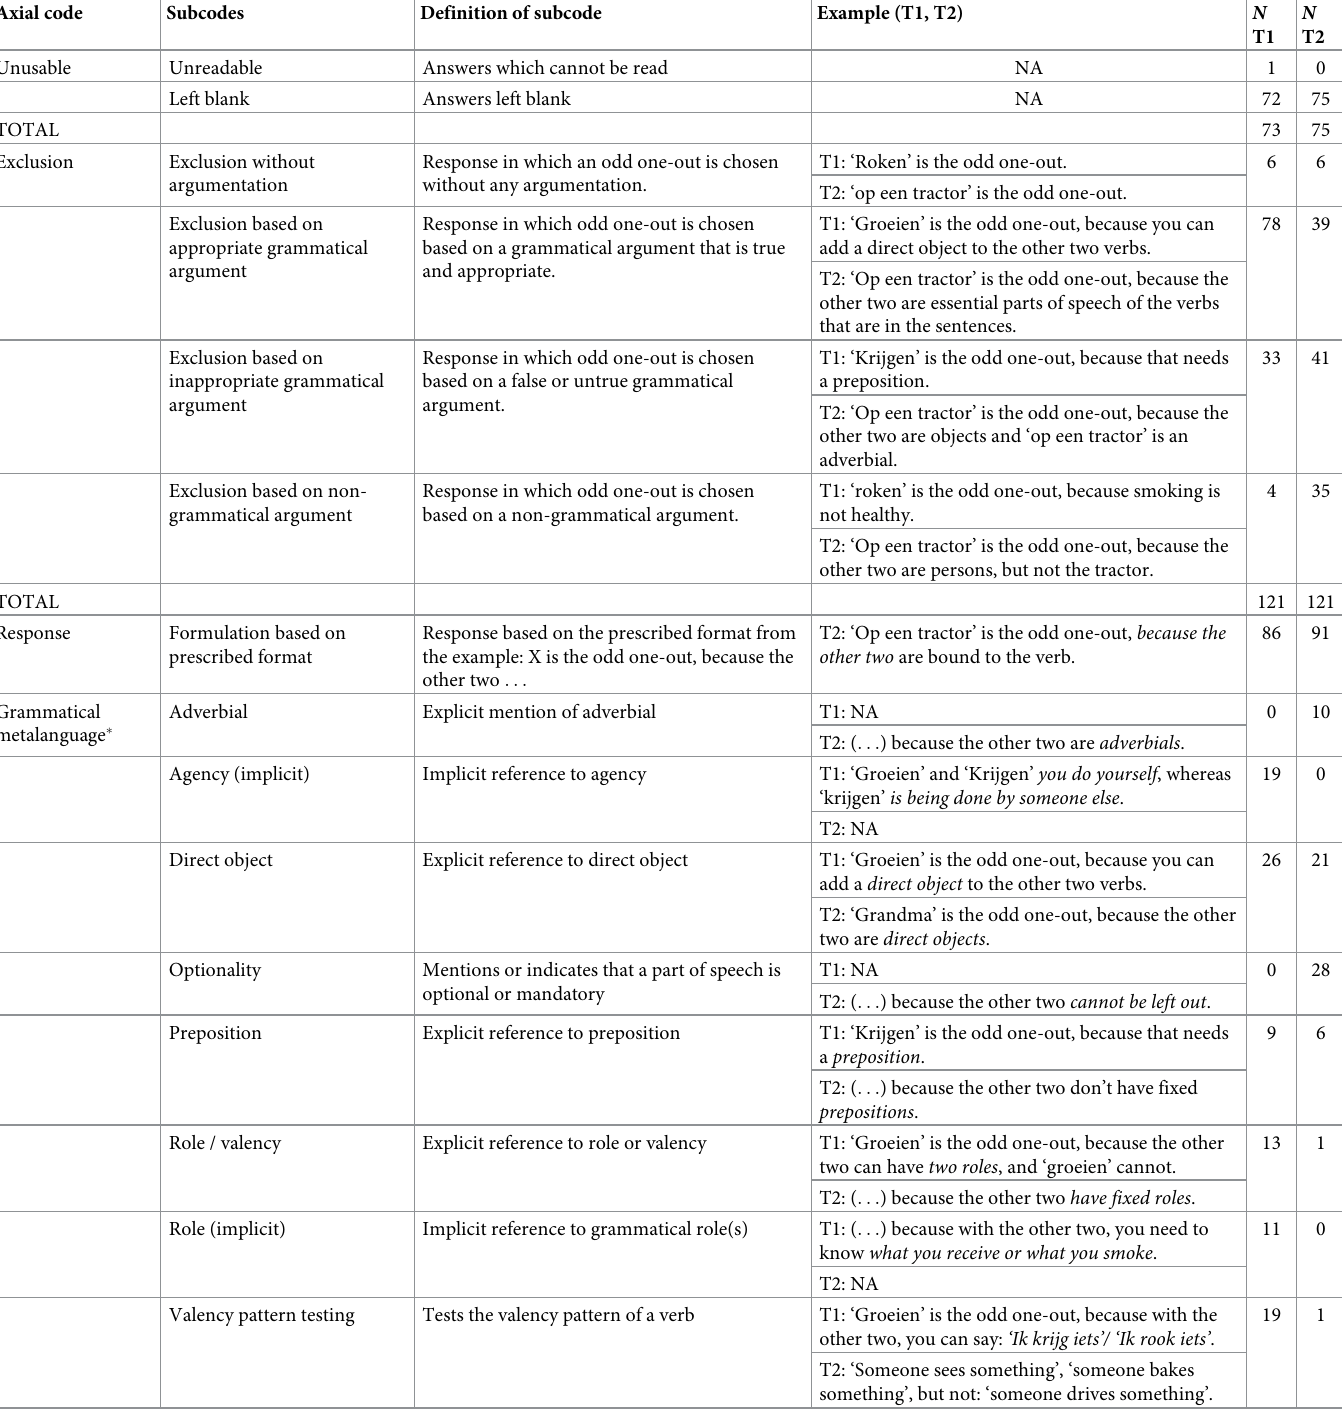
Table 7. Axial codes and subcodes related to key assignment 3 (N = 196, T1: N = 123; T2: N = 121 performed and readable